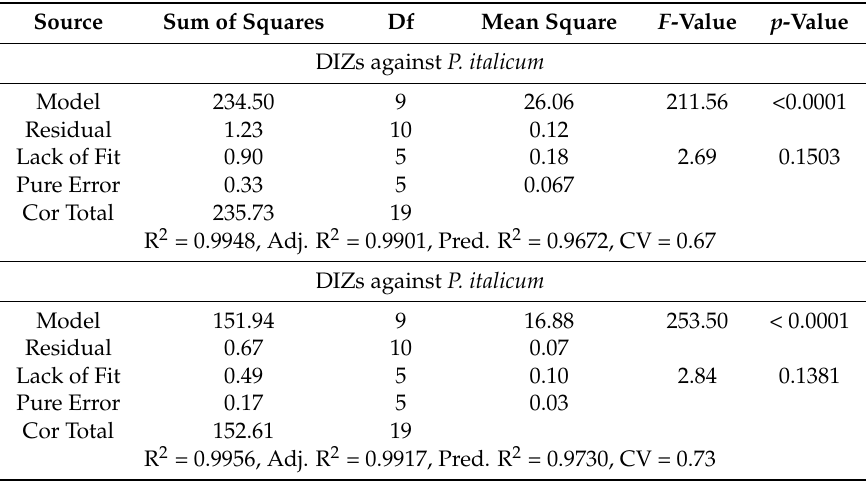
Table 3. ANOVA for the effects of extraction time (X 1 ), solvent to solid ratio (X 2 ) and temperature (X 3 ) on DIZs against P. italicum and P. digitatum